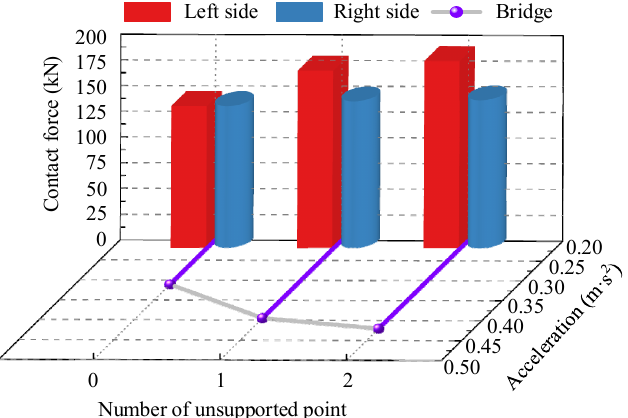
Figure 14. The effect of unsupported track at point B. As can be seen from Figure 15, the maximum displacement of the left-side and right- side rails under one unilateral unsupported sleeper are 0.5355 mm and 0.3729 mm respec- tively, which are about 1.47 times and 1.02 times higher than those under normal support. The maximum acceleration of the left-side and right-side rail under one unilateral unsup- ported sleeper are 31.92 m/s 2 and 24.2 m/s 2 respectively, which are about 1.36 times and 1.03 times higher than those under normal support. It indicates that for the unilateral sup- ported sleeper, the dynamic response of the track has a significant effect on the unsup- ported side, but the effect on the other supporting side can be ignored.